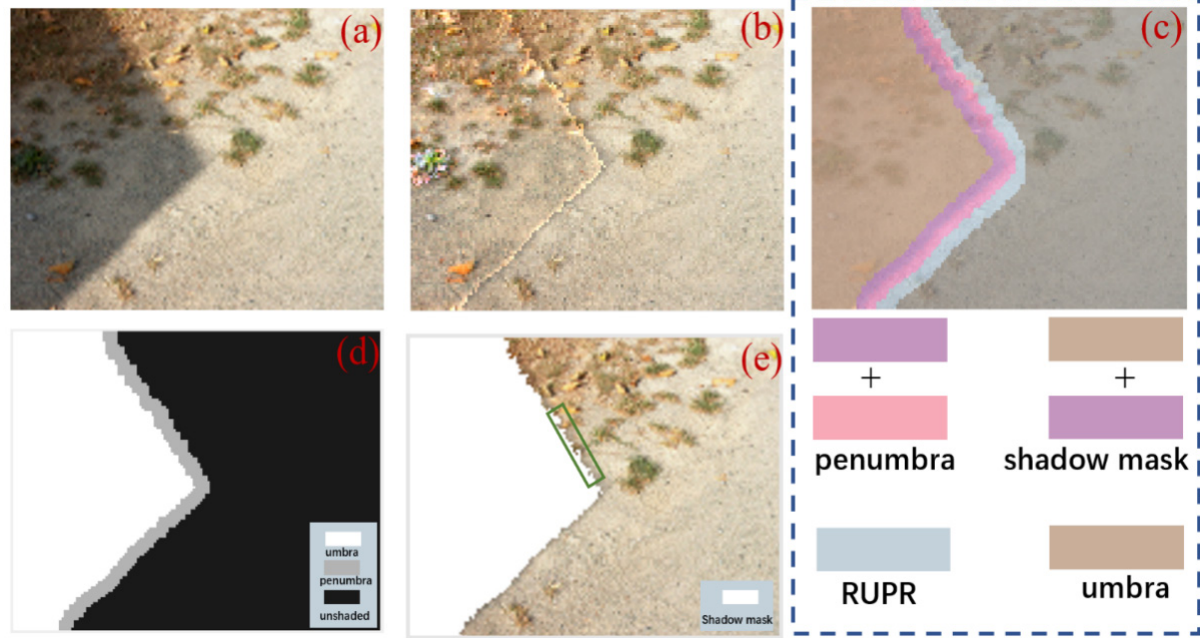
Figure 6. Penumbra removal: ( a ) original image; and ( b ) the result of shadow compensation; ( c ) the region sampled for penumbra removal; ( d ) shadow sketch map: white for umbra, gray for penumbra and black for unshaded region; and ( e ) shadow mask obtained in shadow detection.